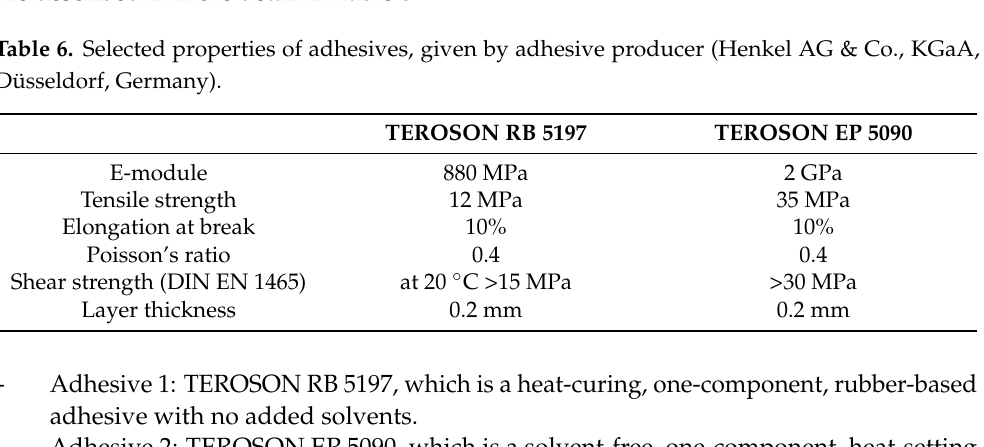
Figure 3. Schematic representation of joint formation using adhesive: ( a ) welding of insert element to aluminum, ( b ) application of adhesive on aluminum substrate, ( c ) welding of steel plate to insert– aluminum joint.